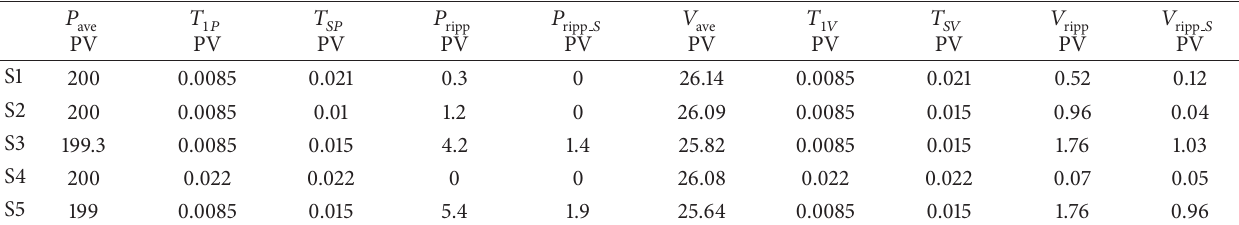
Figure 13: The membership functions of 𝐸 , CE, and 𝐷 for S5. Table 7: The simulation values for PV variables.